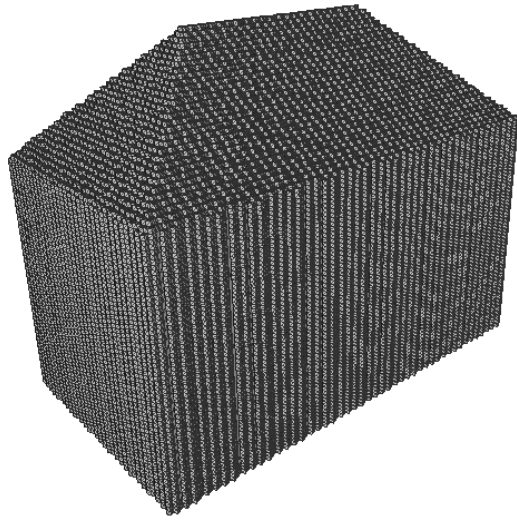
Figure 12: Voxelized test building for the accuracy test. The building was tested with a voxel resolution of 0 . 05 m . For the visualization this building is depicted in a resolution of 0 . 5